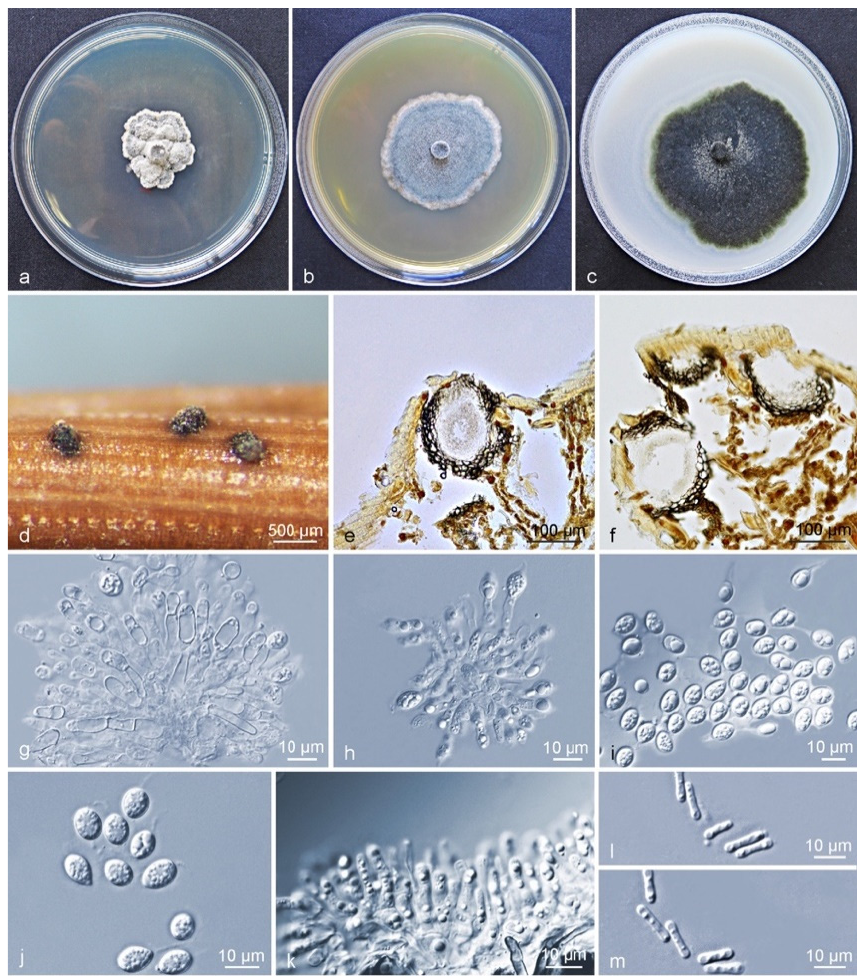
Figure 3. Characteristics of Phyllosticta citriasiana subclade II. ( a – c ) Living culture after 10 d on PDA, MEA, and OA (front). ( d ) Conidiomata formed on pine needle culture; ( e , f ) Longitudinal section through conidiomata; ( g , h ) conidiogenous cells and developing conidia; ( i , j ) conidia with mucoid sheaths and apical appendages; ( k ) spermatial cells giving rise to spermatia; ( l , m ) spermatia. Scale bars: ( d ) = 500 µm; ( e , f ) = 100 µm; ( g – m ) = 10 µm. Culture characteristics (CLW238): Colonies on PDA fl at, grey-white when young, turning leaden-grey and with an irregular bulge after 4–5 d, white at the uneven margin.